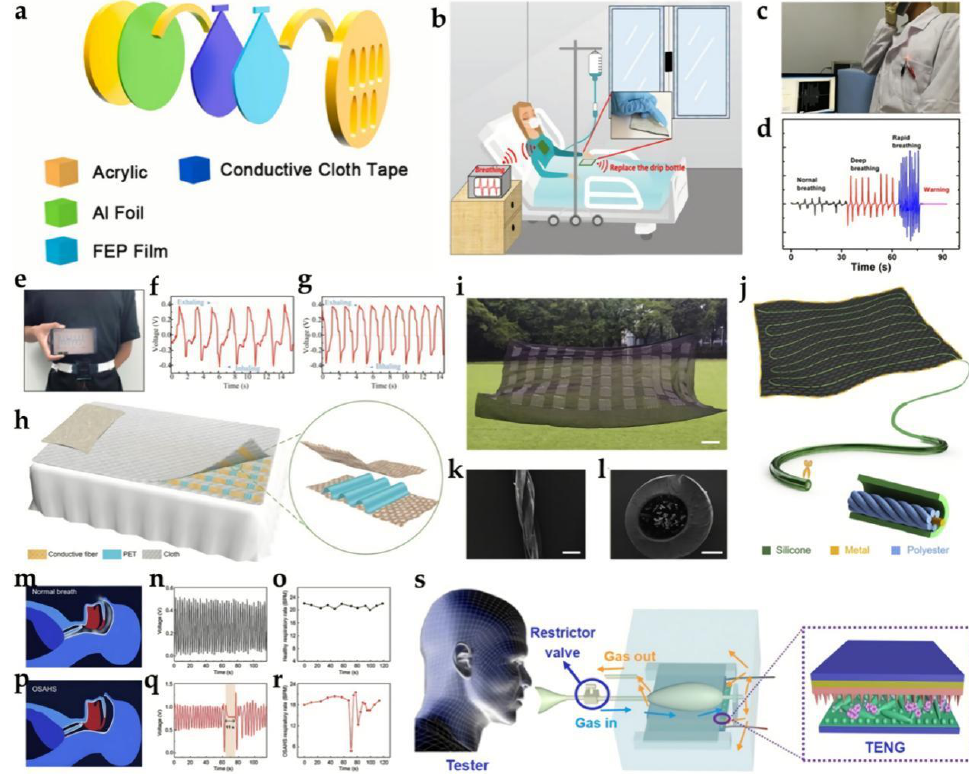
Figure 4. Applications of wearable TENG − based biosensors in pneumology. ( a ) Detailed structure of respiratory-sensing TENG. Reprinted/adapted with permission from Ref. [86]. 2022, Lu et al. Elsevier. ( b ) Wearable TENG for intensive care. ( c , d ) Photograph of respiratory monitoring and the corresponding output current. Reprinted/adapted with permission from Ref. [88]. 2019, Qiu et al. Elsevier. ( e ) Photograph of volunteer’s respiratory waveform displayed on a mobile phone via the wireless transmission system. ( f , g ) Displayed monitoring signals respectively from the 22-year-old volunteer and the 24-year-old volunteer. Reprinted/adapted with permission from Ref. [90]. 2019, Zhang et al. Elsevier. ( h ) Illustration of a 9 × 11 TENG − array − based smart textile. The inset is an enlarged view of one TENG unit of the smart textile. Reprinted/adapted with permission from Ref. [92]. 2018, Lin et al. WILEY-VCH. ( i ) Photograph of the smart textile with 61 sensing units. The scale bar is 10 cm. ( j ) Schematic illustration of a sensing unit, which was fabricated by weaving a washable functional fiber into a black textile substrate with serpentine structure. ( k ) SEM image of the conductive fiber (Scale bar: 300 µ m). ( l ) Cross-section view of the washable functional fiber (Scale bar: 250 µ m). ( m ) Schematic illustration of the smooth airflow into and out of the lungs for a healthy participant, and the corresponding ( n ) respiratory signal and ( o ) respiratory rate. ( p ) Illustration depicting falling soft tissue blocking air from passing through the trachea, inducing OSAHS. ( q ) Respiratory signal and ( r ) respiratory rate of an OSAHS participant. Reprinted/adapted with permission from Ref. [93]. 2020, Zhou et al. Elsevier. ( s ) Schematic illustration of a human respiration-driven system. Reprinted/adapted with permission from Ref. [94]. 2019, Wang et al.